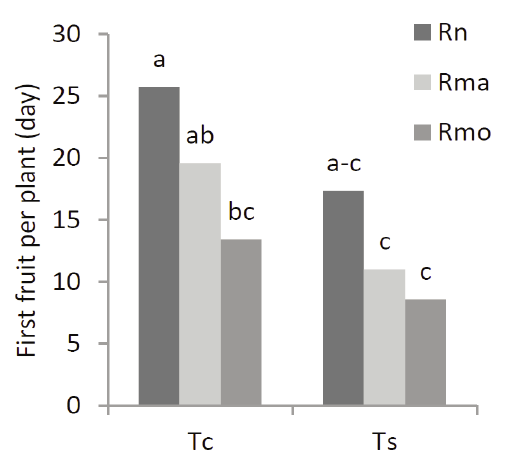
Fig. 5 ­ The interaction effect of temperature and cucumber grafting on the first fruit emergence of a plant. Tc= opti­ mum temperature; Ts= low temperature; Rn = nongraf­ ted ( Cucumis sativus var. DavosII); Rs= self grafted; Rma= Cucurbita maxima ; Rmo= Momordica charantia .